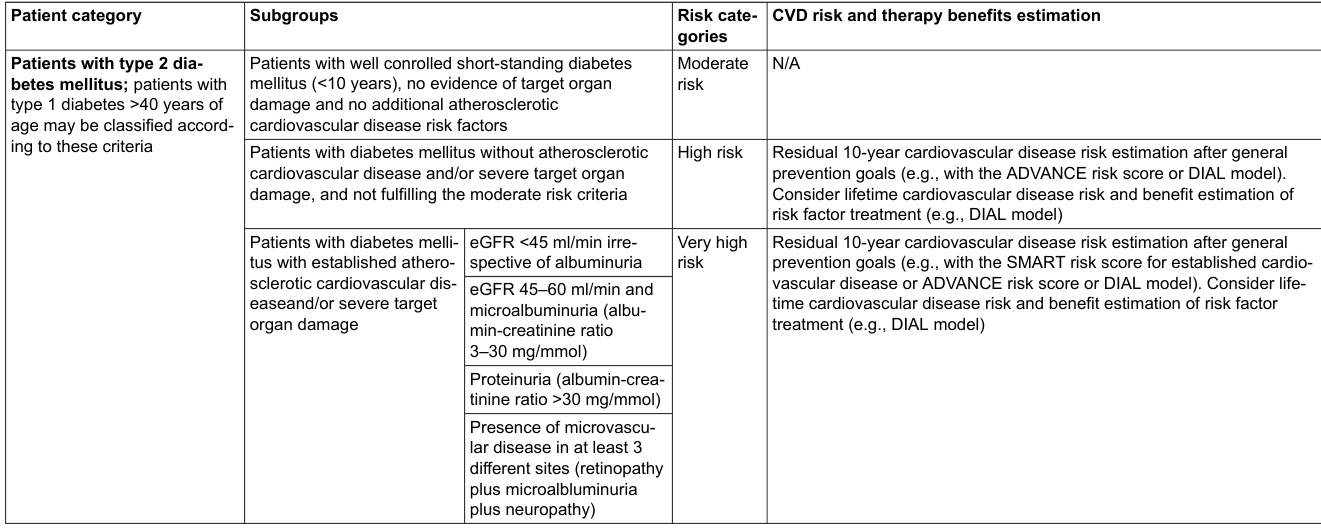
CVD risk and therapy benefits estimation gories